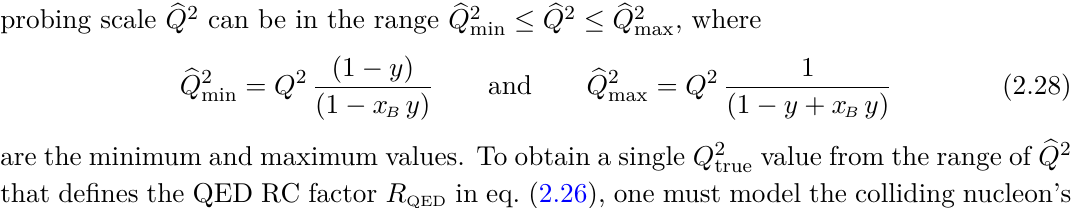
√ , at Jefferson Lab ( s = 4 . 7 GeV) (left) and EIC ( B